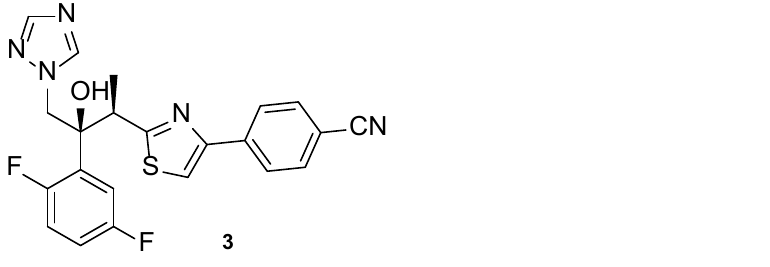
Figure 7. Chemical structure of isavuconazole ( 3 ), a novel triazole antifungal agent [41]. Isavuconazoles’ antifungal activity against Candida , Aspergillus , Mucorales, Fusarium, and Scedosporium has been studied. When tested against Aspergillus species, isavuconazole ( 3 ) presented promising antifungal results, with MIC values similar/comparable to those of voriconazole [41]. Additionally, when tested against azole-resistant Aspergillus lentulus , isavuconazole ( 3 ) displayed promising activity [42]. Against Mucorales species, which was little susceptible to the standard voriconazole, isavuconazole ( 3 ) displayed little